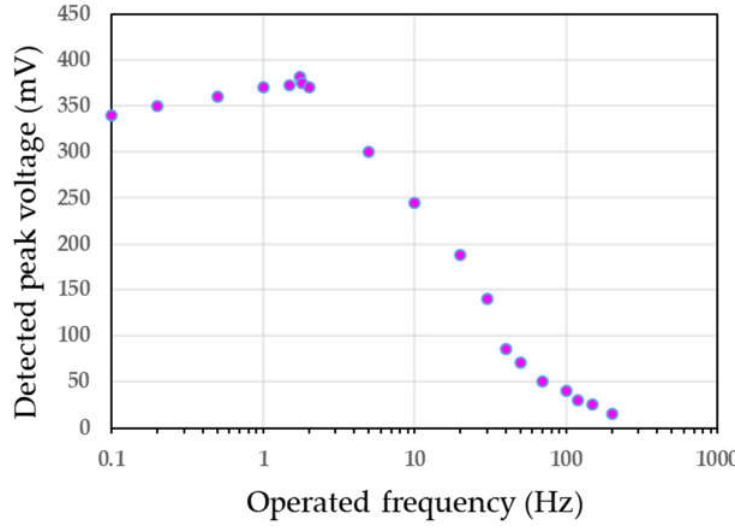
Figure 9. Frequency response of the acoustic vibration experiment from 0.1 to 200 Hz.